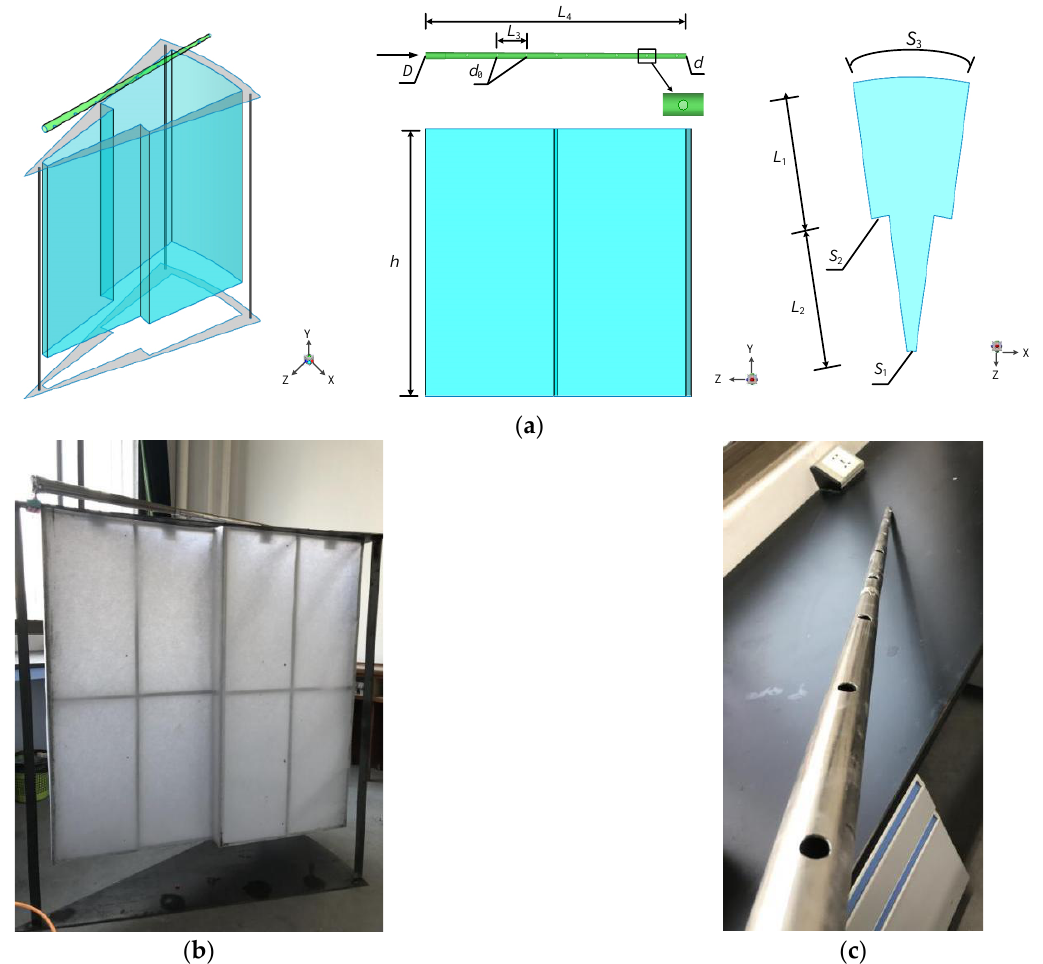
Figure 1. Experimental device for the dust cleaning performance of the NSMMFP ( a ) The experi- mental device diagram and system schematic diagram of the wall surface peak pressure test. ( b ) The powder-attached experimental device diagram and principal diagram.